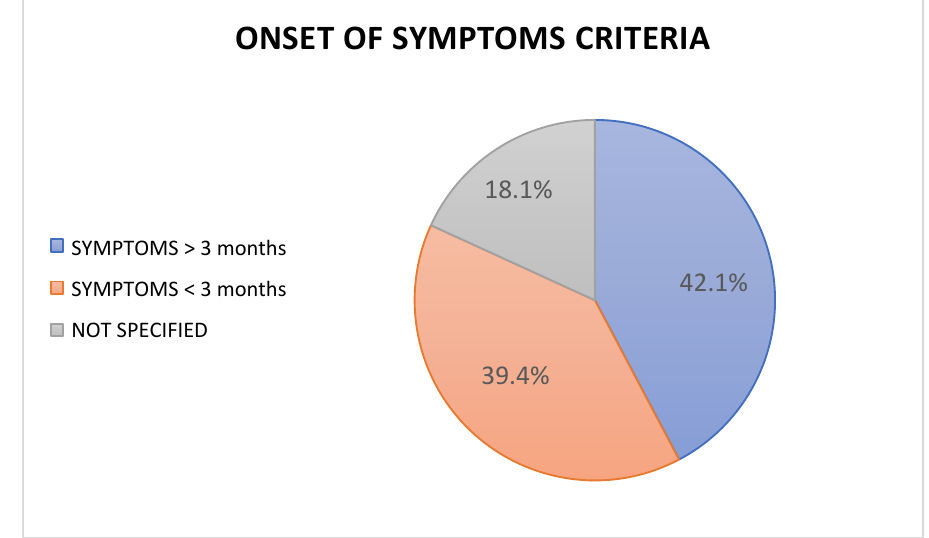
Figure 4. Onset of symptom criteria for LEP reported in the selected studies.